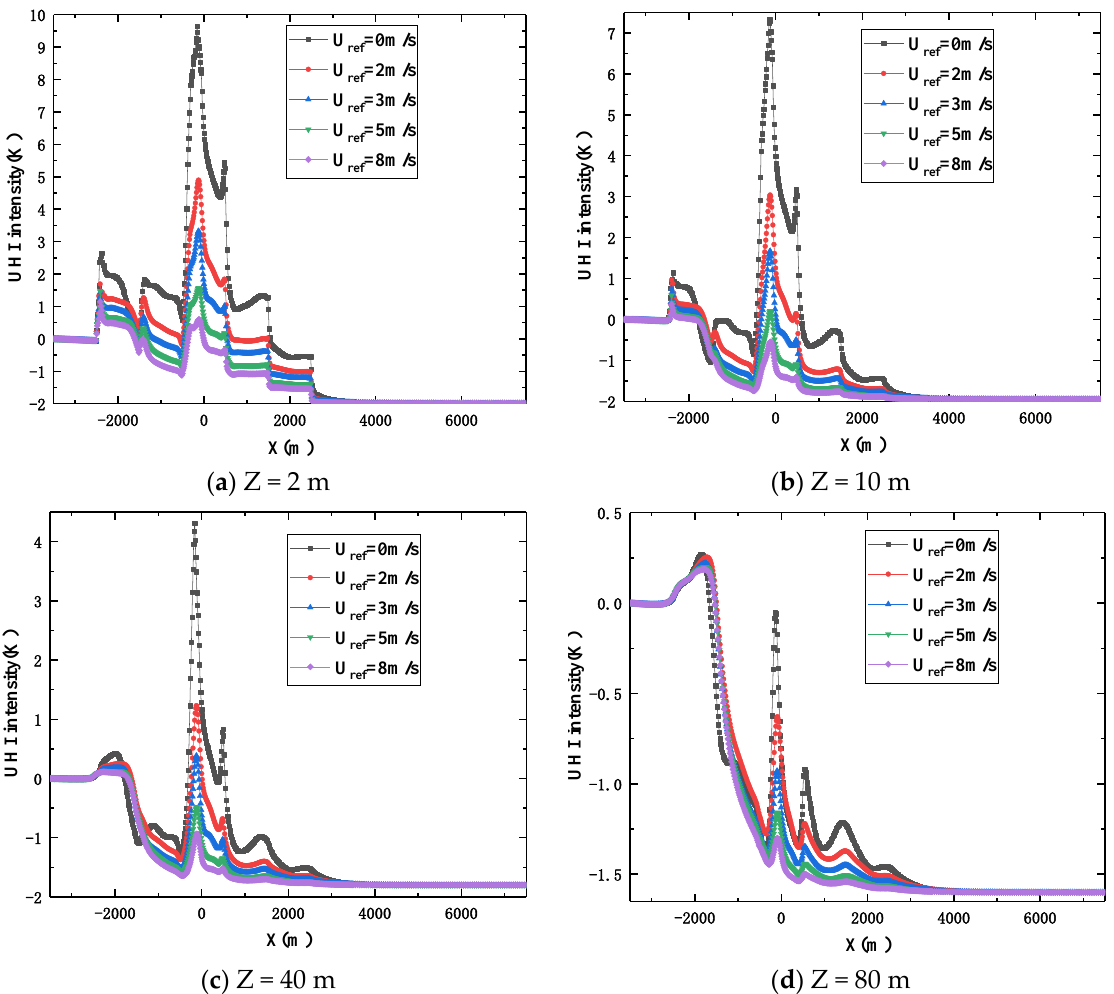
Figure 9. The horizontal profiles of the UHI intensities at different ambient crosswind speeds at heights of ( a ) 2 m, ( b ) 10 m, ( c ) 40 m, and ( d ) 80 m in the plane y = 0.